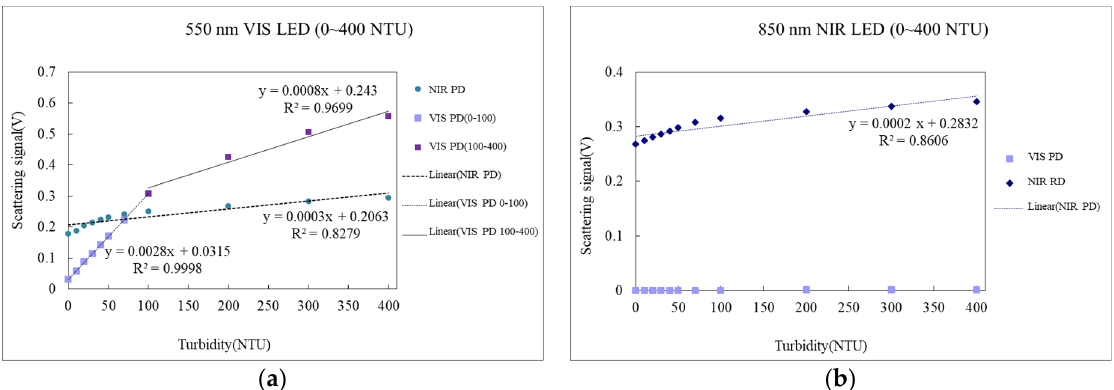
Figure 4. Results of testing of turbidity sensing modules for scattering signals. ( a ) 550 nm LED. ( b ) 850 nm LED.